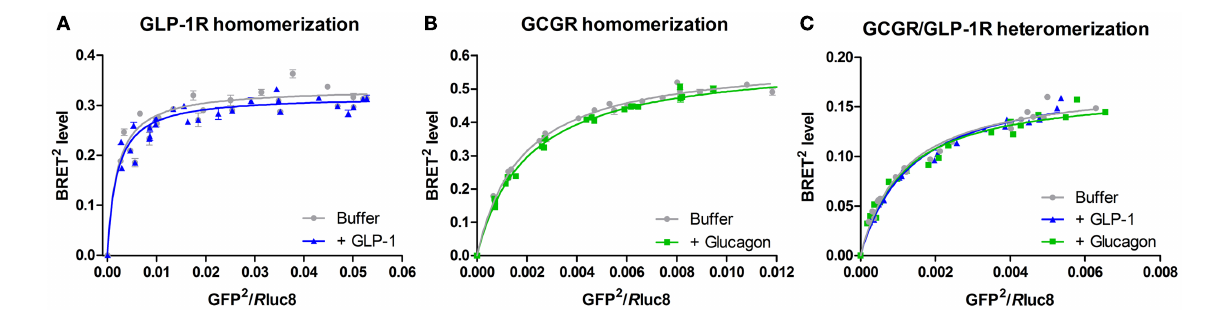
control) for 5min at room temperature.The BRET 2 signal was measured upon addition of the R luc8 substrate, DeepBlueC in a Mithras plate reader. All